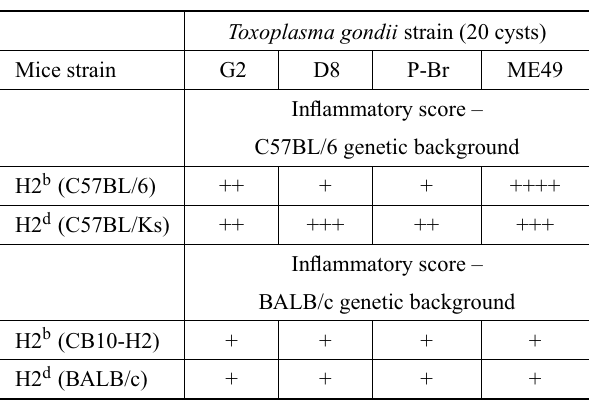
Inflammatory lesions on small intestine of mice infected with different strains of T. gondii .